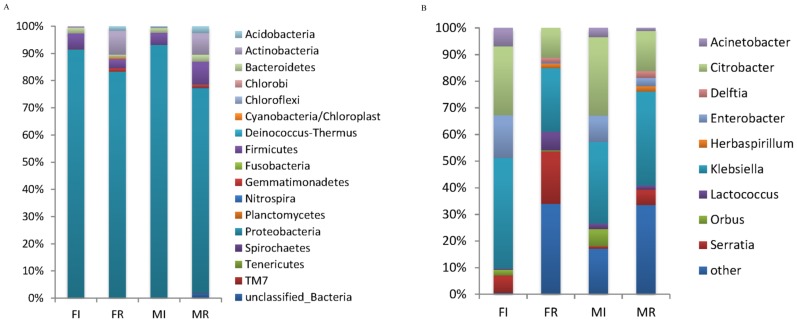
Taxonomic classification of bacterial reads retrieved from different samples with a confidence threshold of 50%.(A) Relative abundance of bacterial at phylum level. (B) Relative abundance of top 15 bacterial genera. Abbreviations: FI, female-intestine; FR, female-ovary; MI, male-intestine; MR, male-testis.